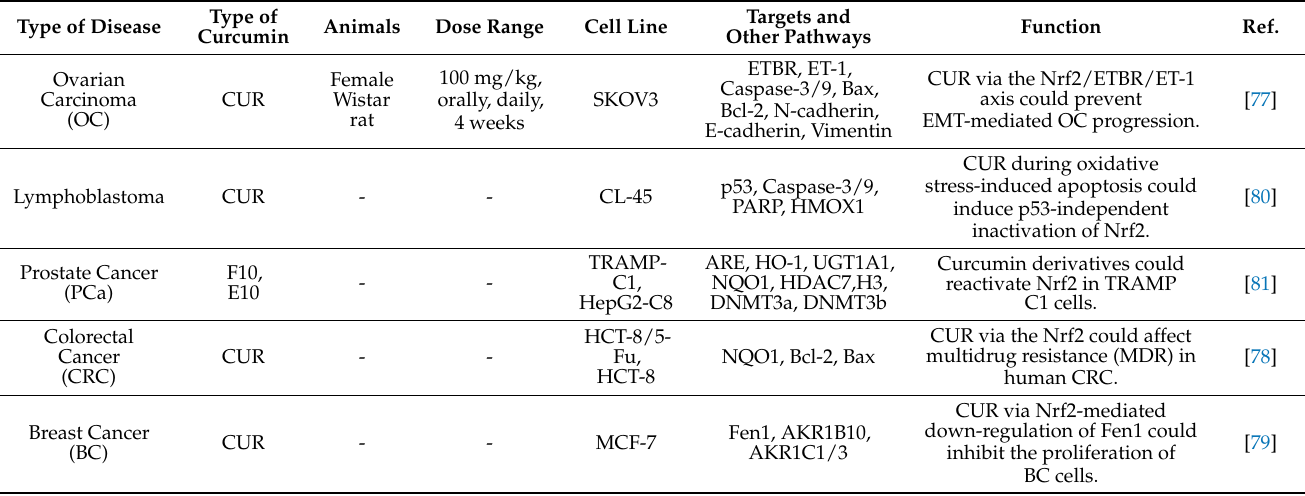
Table 8. Nrf2-related therapeutic effects of curcumin in